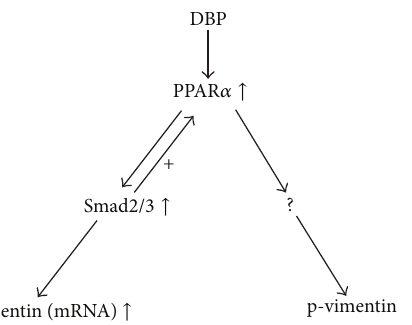
Figure 5: Schematic diagram of the relationship between PPAR 𝛼 and Smad2/3 in regulation of vimentin in DBP-exposed SCs. DBP stimulated the activity of PPAR 𝛼 , activated PPAR 𝛼 promoted the activity of Smad2/3, and activated Smad2/3 upregulated the vimentin mRNA expression. As SB431542 inhibited Smad2/3 and could inhibit PPAR 𝛼 to some extent, we deduced that Smad2/3 may have a positive feedback response to PPAR 𝛼